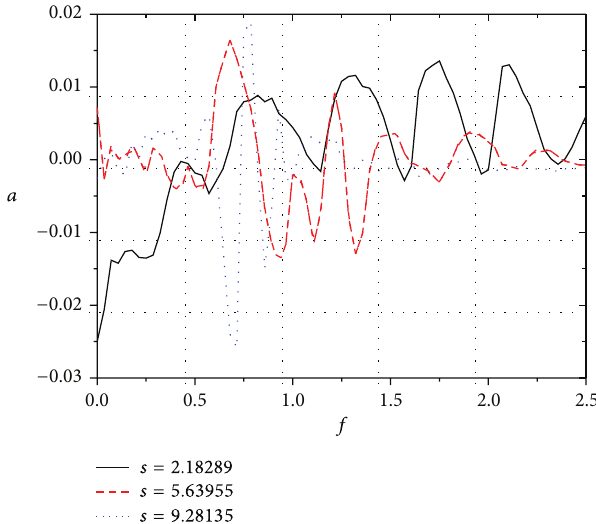
Figure 11: Growth of different frequency disturbances in boundary layer along streamwise under freestream pulse fast acoustic